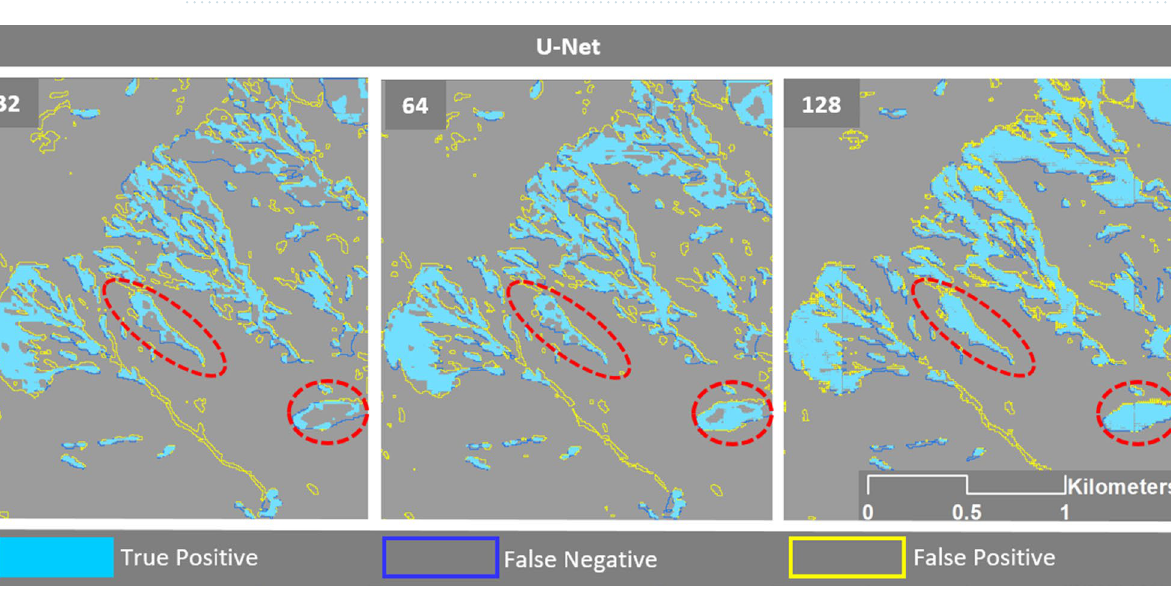
Figure 12. Comparison of how different window sizes affected the U-Net results in Taiwan. The maps were created using Python 3.6 (https:// www. python. org/) and the ArcMap v.10.8 software (https:// deskt op. arcgis. com/ es/